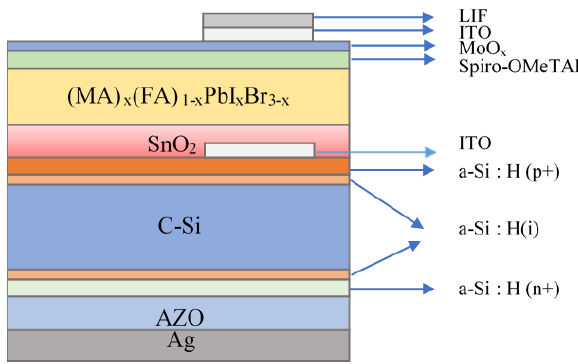
Figure 13: Monolithic perovskite / silicon tandem cell